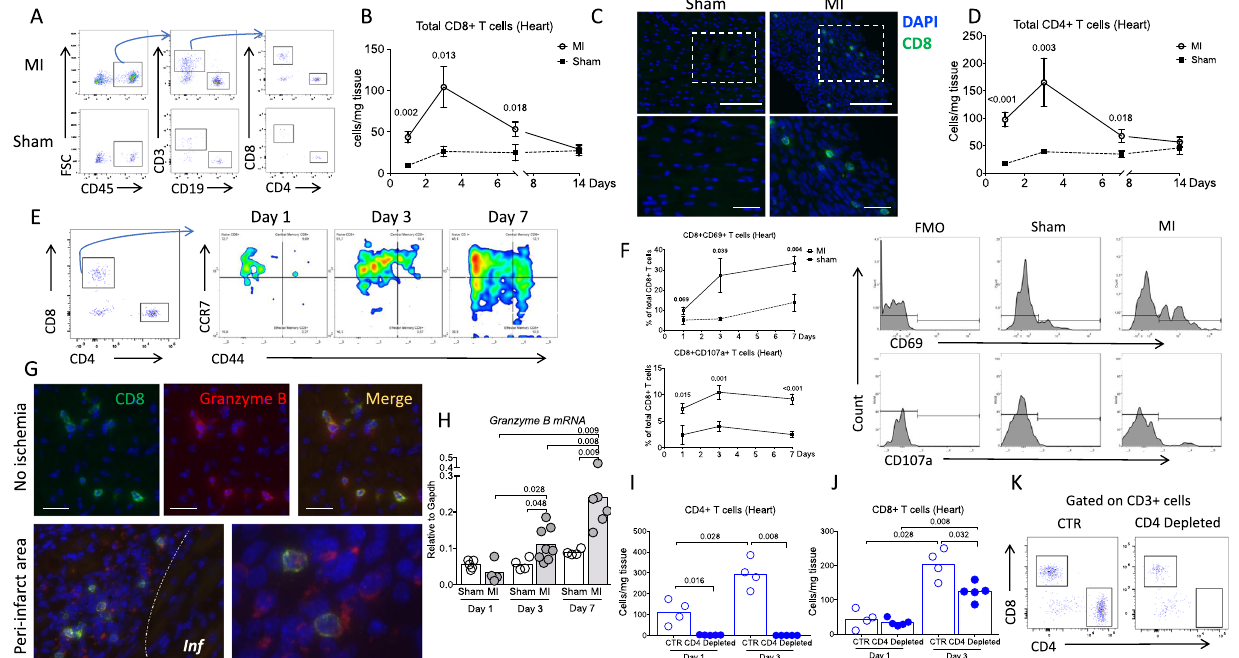
Fig. 1 Cytotoxic CD8 + T lymphocytes are activated and recruited to the ischemic tissue after myocardial infarction. A Representative examples of CD4 + and CD8 + T cell staining in the heart of C57BL/6J mice following coronary ligation (MI) or sham surgery. B Kinetic of CD8 + T cell in fi ltration in the myocardium, performed at days 0, 1, 3, 7, and 14 after surgery in MI (white circle, n = 9/12/12/5, respectively, at day 1/3/7/14) and sham-operated mice (black box, n = 6/time point); data are presented as mean ± SEM. C Immunostaining in the ischemic myocardium at day 3 after MI or sham showing CD8 + T in fi ltration (green) in the ischemic heart tissue, scale bar 40 μ m. D Kinetic of CD4 + T cell in fi ltration in the myocardium, performed at days 0, 1, 3, 7, and 14 after surgery in MI (white circle, n = 10/9/12/5, respectively, at day 1/3/7/14) and sham-operated mice (black box, n = 6/time point); data are presented as mean ±SEM. E Flow cytometry characterization of CD8 + T cell subsets in the ischemic heart at days 1, 3, and 7 after MI including naïve (CD3 + CD8 + CCR7 High CD44 − ), effector memory (CD3 + CD8 + CCR7 Low CD44 + ), and central memory (CD3 + CD8 + CCR7 High CD44 + ) subsets. F Representative examples and quantitative analysis of CD8 + T cells expressing CD69 or CD107a within the ischemic heart tissue in MI (white circle, n = 6/9/12, respectively, at day 1/ 3/7) and sham-operated mice (black box, n = 6/time point); data are presented as mean ± SEM. G Immunostaining in the ischemic myocardium at day 3 after MI showing CD8 + T cells (green), and Granzyme B (Red) and merged area (Yellow), Inf for infarct area; scale bar 40 μ m. H mRNA levels of Granzyme B within the injured myocardium on days 1, 3, and 7 after coronary ligation (gray, n = 5/4/5 at day 1/3/7) or sham (white, n = 4/8/6 at day 1/3/7). I C57Bl6 WT mice received intraperitoneal injection of isotype control (CTR, blue borderline, n = 4/time point) or anti-CD4 depleting monoclonal antibody (blue fi lled, n = 5/time point) (150 μ g/mice) 1 day before coronary occlusion. CD4 + T cell depletion was con fi rmed in the heart by fl ow cytometry at day 1 and day 3 following MI. J , K Quanti fi cation and representative example of CD8 + T cell count in the heart of control ( n = 4/time point) or CD4-depleted ( n = 5/time point) mice at day 1 and day 3 after MI. P values were calculated using two-tailed Mann-Whitney test ( B , D , F , H , I , J ). Inf, infarct; MI, myocardial infarction; FMO, fl uorescent minus